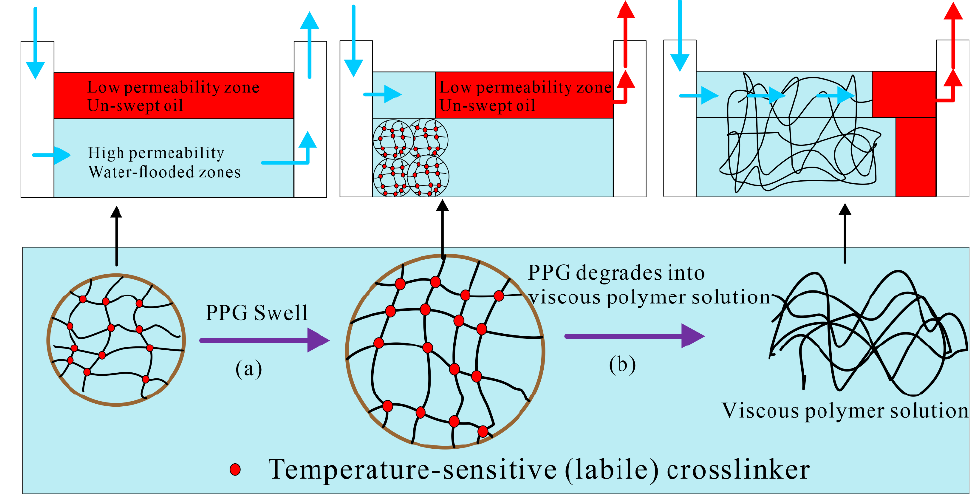
Figure 5. Mechanism of high-temperature stable/unstable crosslinker composite PPGs. ( a ) PPG Swells. ( b ) PPG degrades into viscous polymer solution. (Adapted from Ref. [41]. 2013, B ai, et al”) .